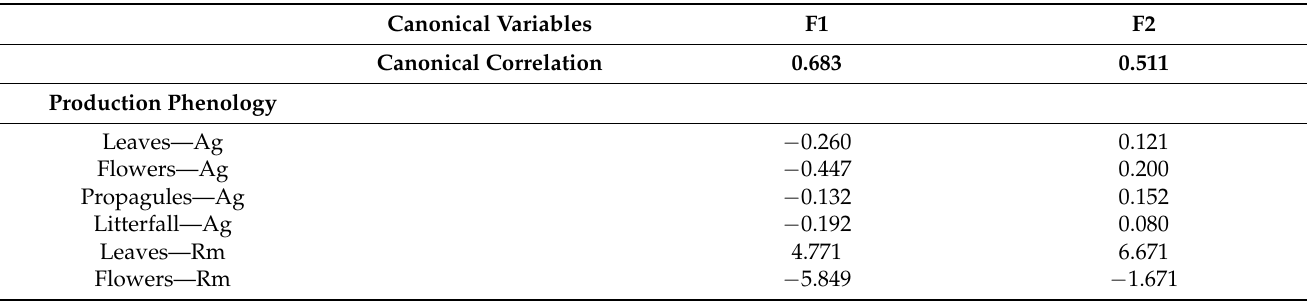
Table 8. Canonical correlation between three mangrove species’ phenological production and